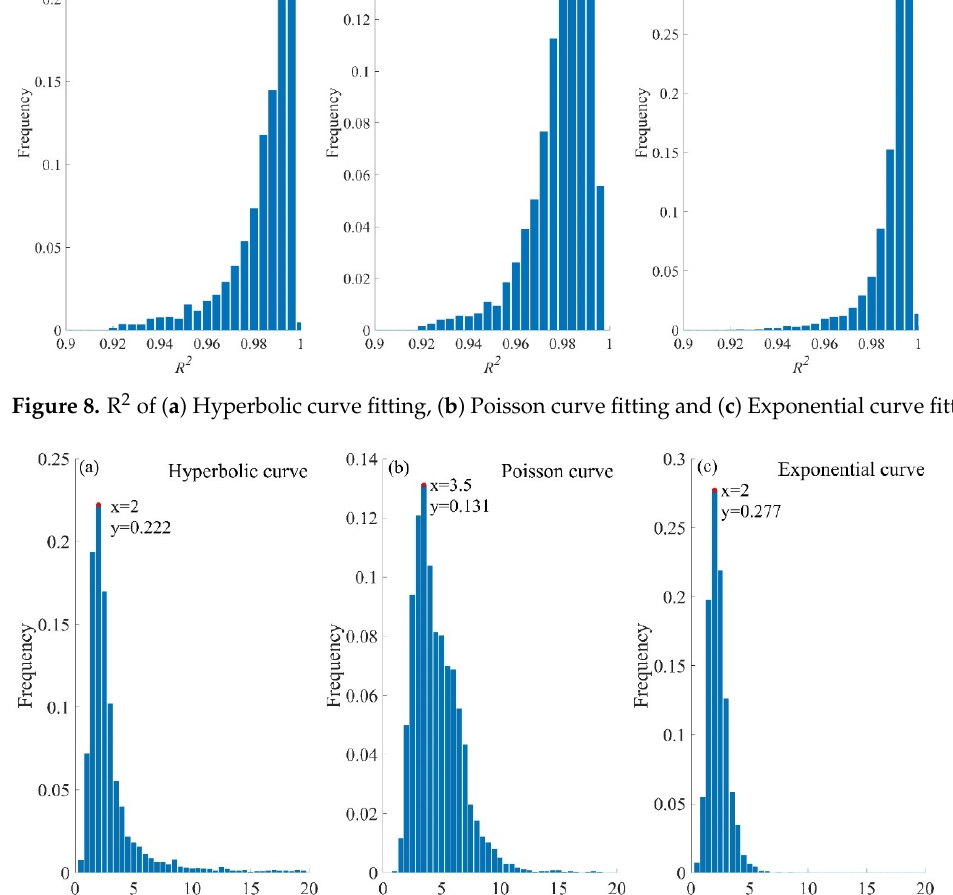
Figure 8. R 2 of ( a ) Hyperbolic curve fitting, ( b ) Poisson curve fitting and ( c ) Exponential curve fitting.